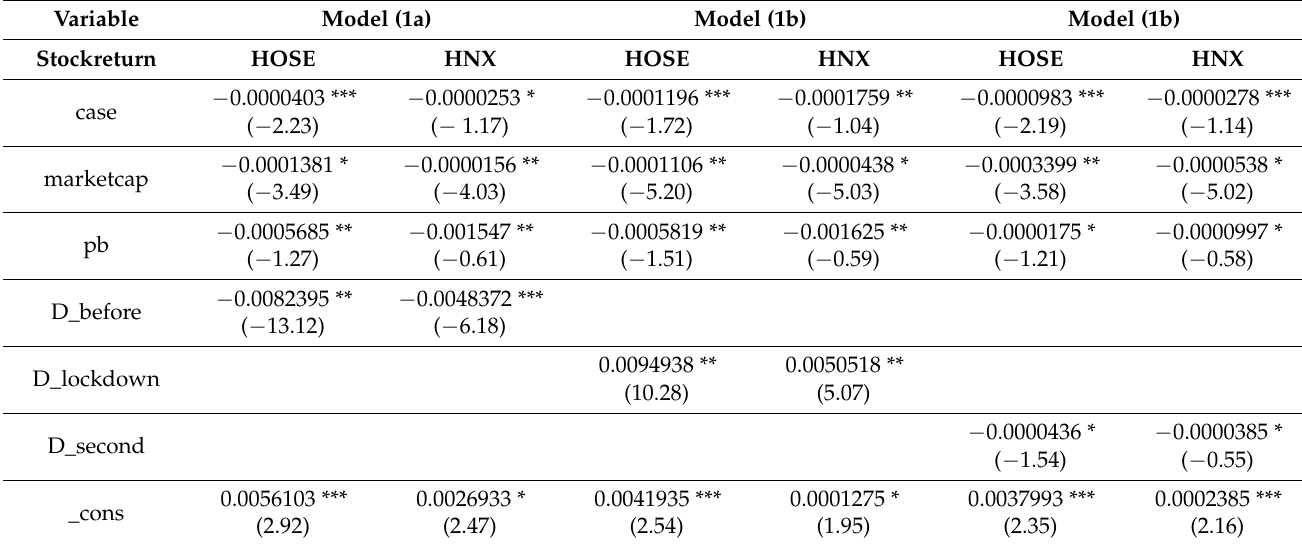
Table 5. The impact of COVID-19 on the Vietnamese stock market during pre-lockdown, lockdown and second wave periods.